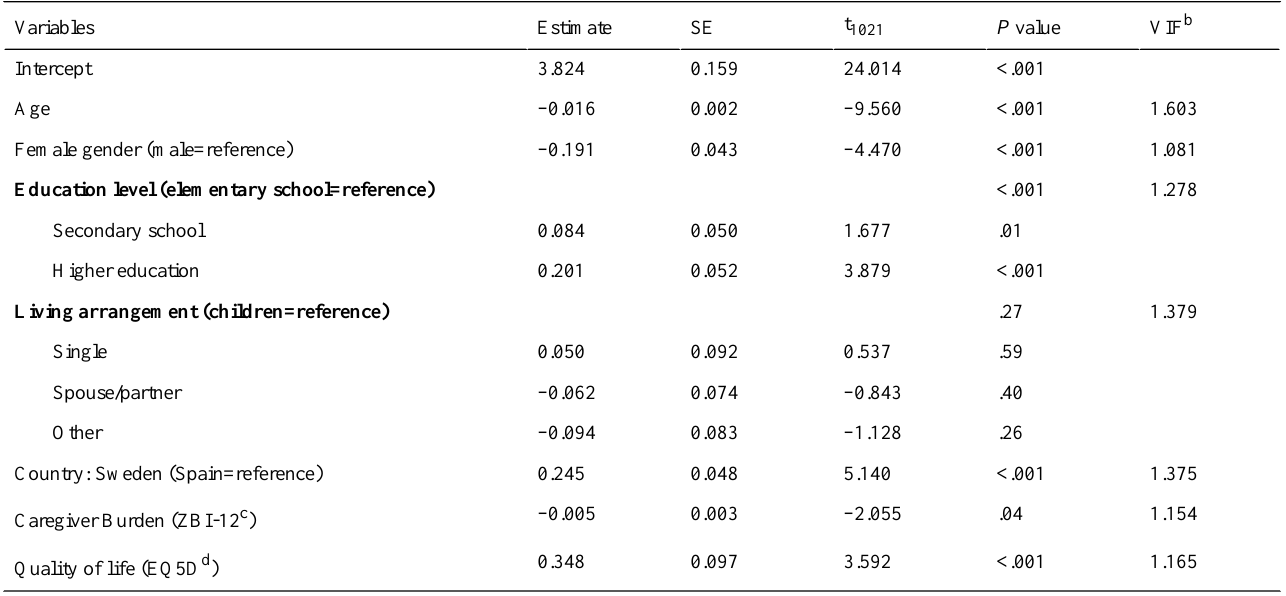
Table 4. Multivariate linear regression model a of factors associated with technophilia in